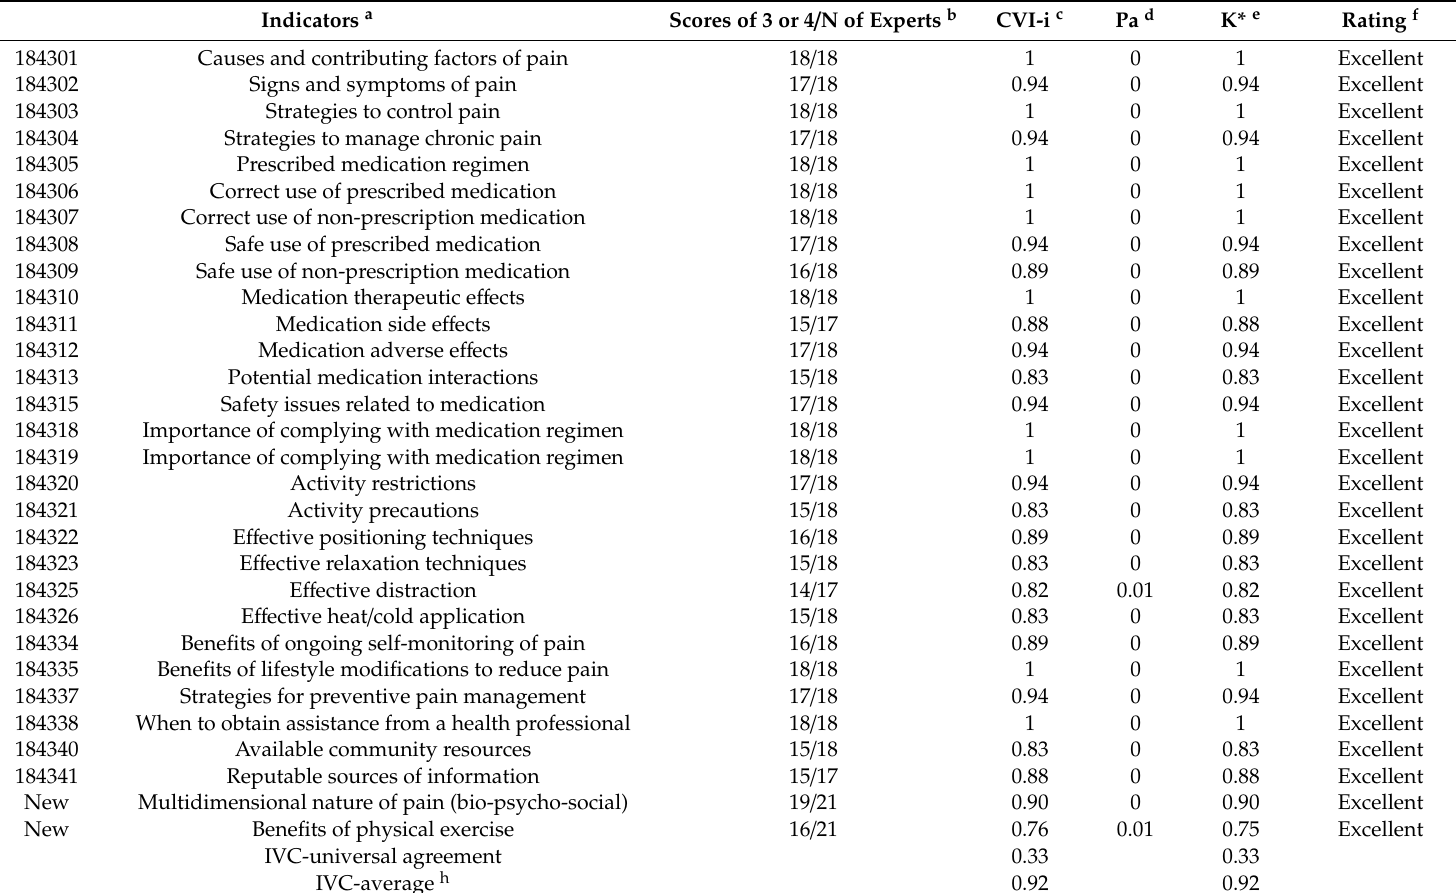
Table 2. Content validity index and ratings of the indicators of the outcome Knowledge: Pain